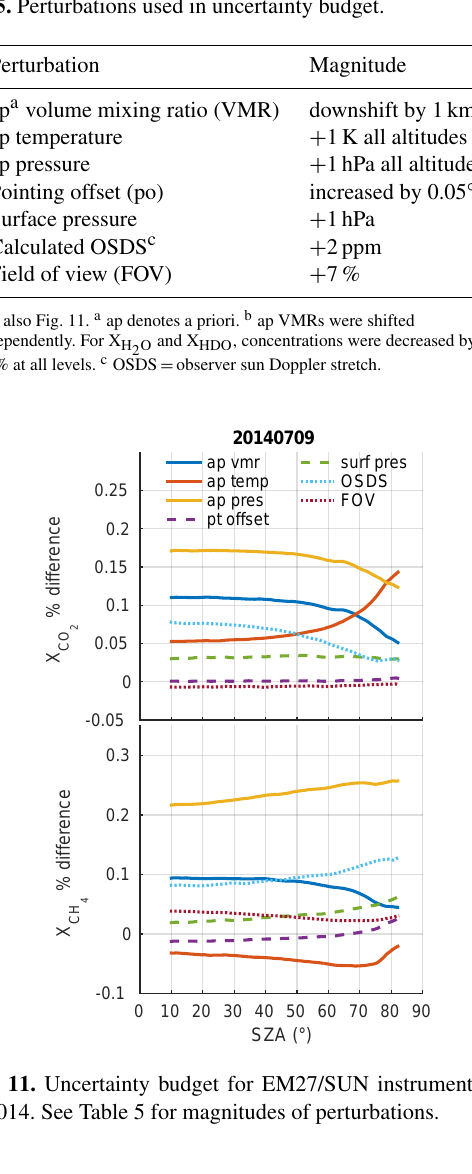
Table 5. Perturbations used in uncertainty budget.